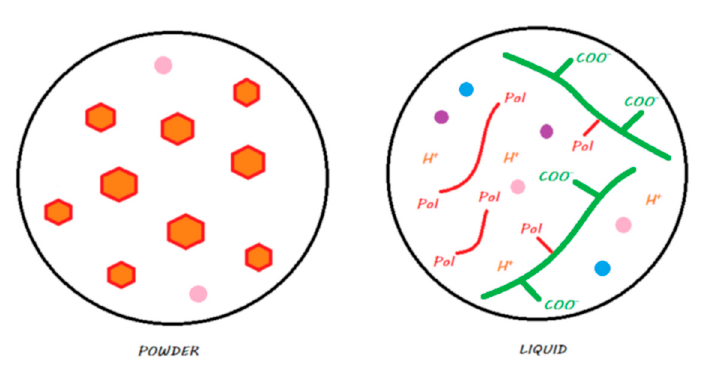
Figure 8. Vitremer in its storage medium. The powder contains silanated FAS fillers, and some chemopolymerization components are added. The liquid contains water, an ionized modified polyacrylic acid with photopolymerizable groups, camphorquinone as a photoinitiator, and some chemopolymerization components.